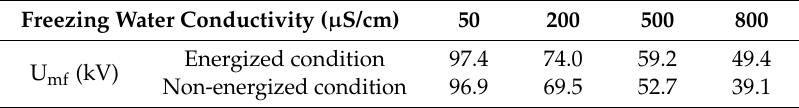
Table 5. Influence of freezing water conductivity on flashover